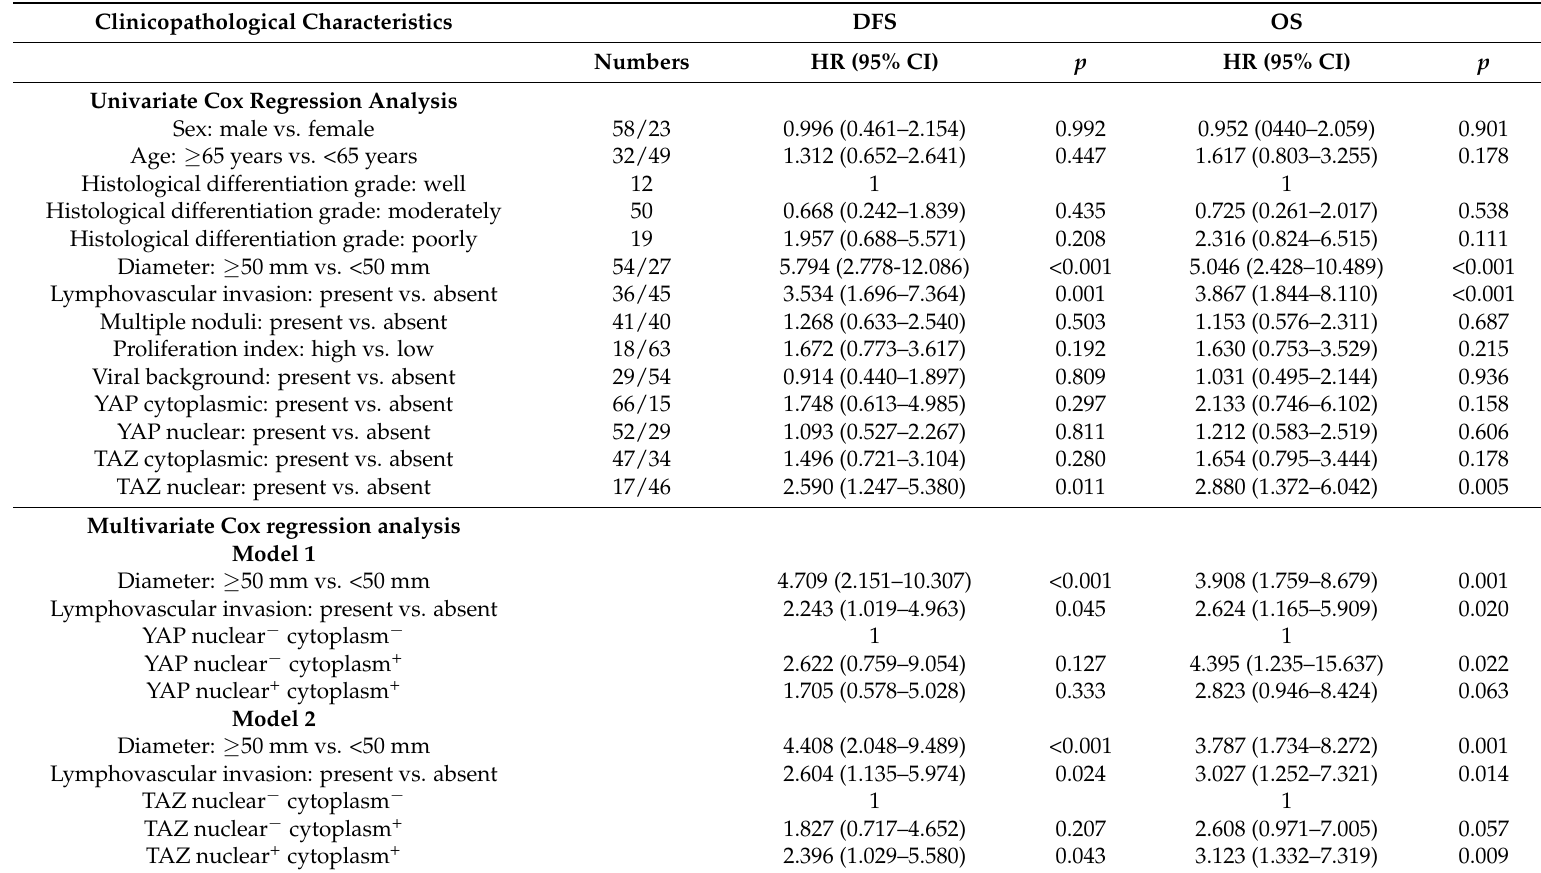
Table 3. Univariate and multivariate analysis for overall survival and disease-free survival in HCC K19 − . Clinicopathological